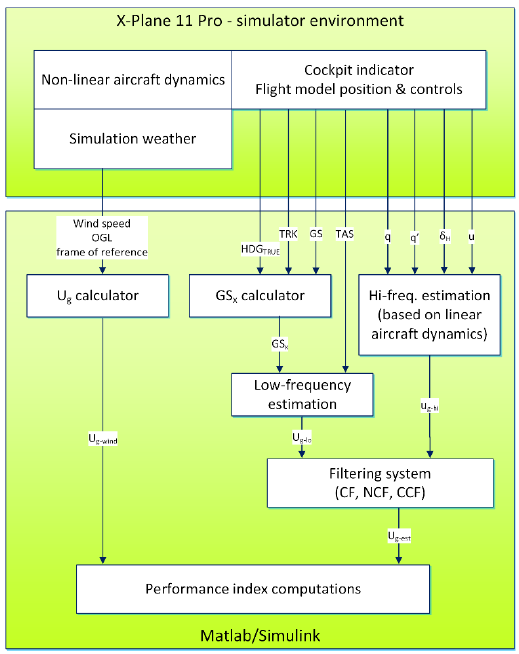
Figure 11. Flight simulation and wind parameter estimation—data flow scheme.